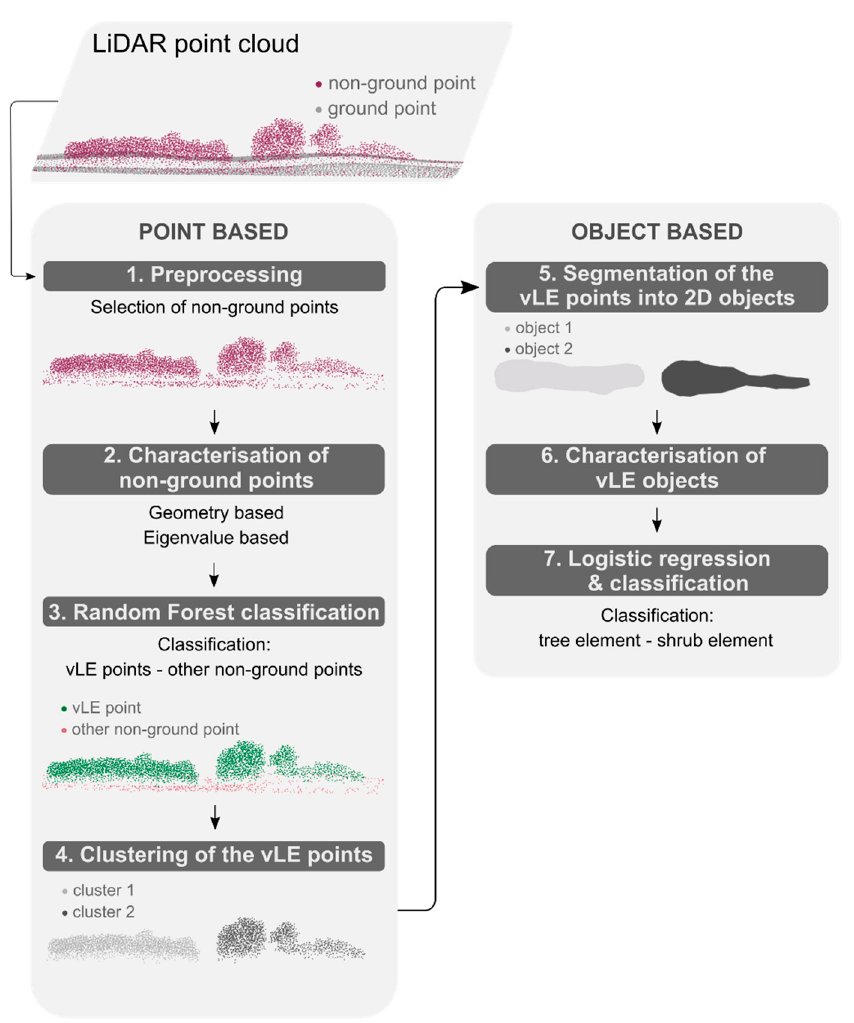
Figure 3. Schematic representation of the workflow applied to classify LiDAR points into vLE ob- jects.